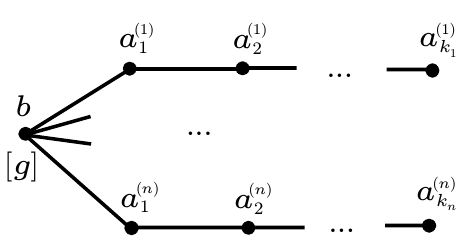
Figure 11 . A plumbing graph for a Seifert